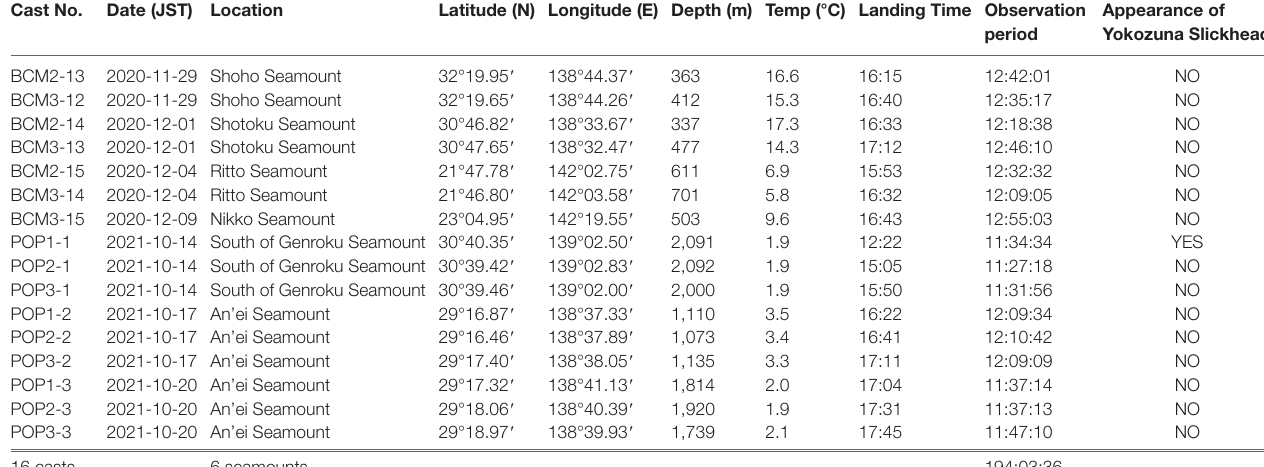
TABLE 2 | Summary of baited camera deployment. Cast No. Date (JST)